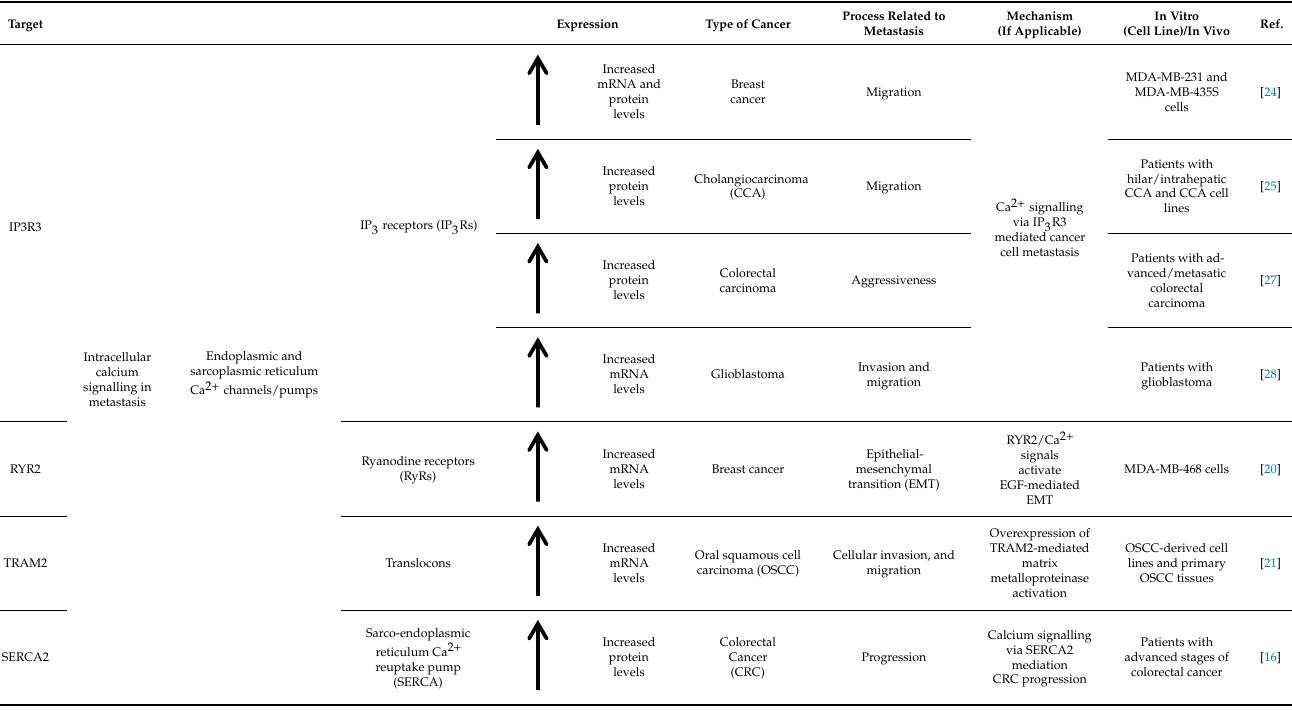
Table 1. Some experimental evidence supporting Ca +2 signalling-mediated cancer metastasis.